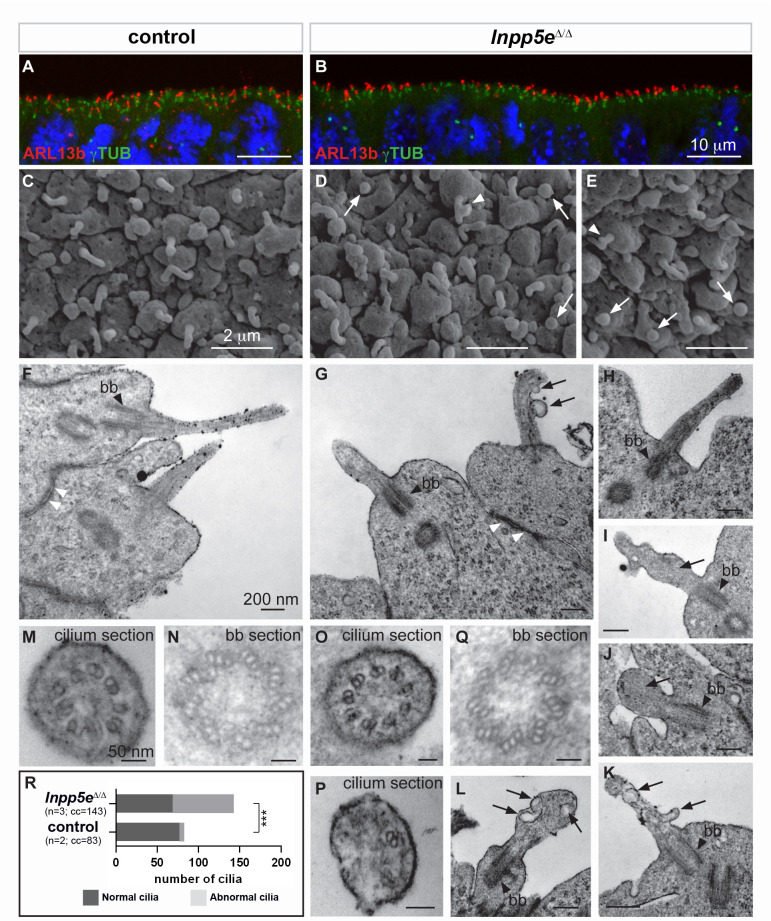
Ciliary defects in E12.5 Inpp5eΔ/Δ forebrain.(A–B) Immunohistochemistry for Arl13b and γ-Tubulin (γTUB) on E12.5 brain cryosections showed an accumulation of ciliary axonemes and basal bodies, respectively, at the apical border of radial glial cells facing the ventricules in both control (A) and Inpp5eΔ/Δ (B) embryos without any gross difference. Scale bars: 10 μm. (C–E) Scanning electron microscopy (SEM) on E12.5 control (C) and Inpp5eΔ/Δ (D, E) brains highlighted the presence of primary cilia projecting from the apical surface of radial glial cells in both control (A) and Inpp5eΔ/Δ (B) embryos. However, SEM also revealed the presence of abnormal cilia in Inpp5eΔ/Δ embryos having a spherical shape (arrows in D and E) or aberrant lateral buddings (arrowheads in D and E). Scale bars: 2 μm. (F–L) Transmission electron microscopy (TEM) analysis on E12.5 brains showed longitudinal sections of primary cilia in control (F) and Inpp5eΔ/Δ (G–L) embryos. In control primary cilia, the axoneme appeared as an extension of the basal body (bb, black arrowheards) (F–H). In addition to cilia with normal morphology, abnormal cilia were identified in Inpp5eΔ/Δ embryos thanks to the presence of a basal body apparently correctly docked to the apical membrane. Abnormal cilia lacked an axoneme (I, J, L) or showed unusual membranous structures, such as budding (G, K) or internal (I, K, L) vesicles (arrows) or undulating peripheral membranes (I). Note that tight junctions (white arrowheads in F and G) appeared normal in Inpp5eΔ/Δ (G) and control (F) embryos, suggesting that apico-basal polarity of Inpp5eΔ/Δradial glial cells was not compromised. Scale bars: 200 nm. (M–Q) TEM images showing transverse sections of the axoneme (M, O, P) and the basal body (N, Q) in control (M, N) and Inpp5eΔ/Δ (O–Q) embryos with no major difference in the basal bodies between control (N) and Inpp5eΔ/Δ (Q) embryos. However, transverse section of primary cilia in Inpp5eΔ/Δ brains revealed the presence of normal axonemes composed of nine correctly organized doublets of microtubules on some radial glial cells (O), while others harbored an abnormal axoneme containing a lower number of microtubule doublets (P). Scale bars: 50 nm. (R) Graph showing the number of normal versus abnormal cilia (cil.) found on TEM images from control (n = 3) or Inpp5eΔ/Δ (n = 3) embryos. cc: counted cilia.